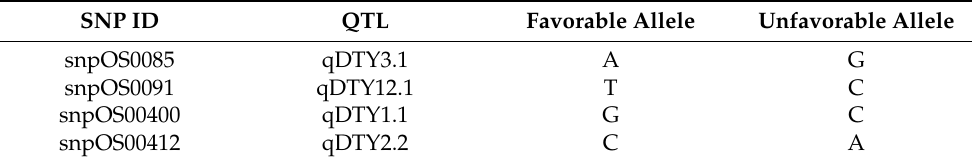
Table 6. SNP markers and targeted QTLs for drought